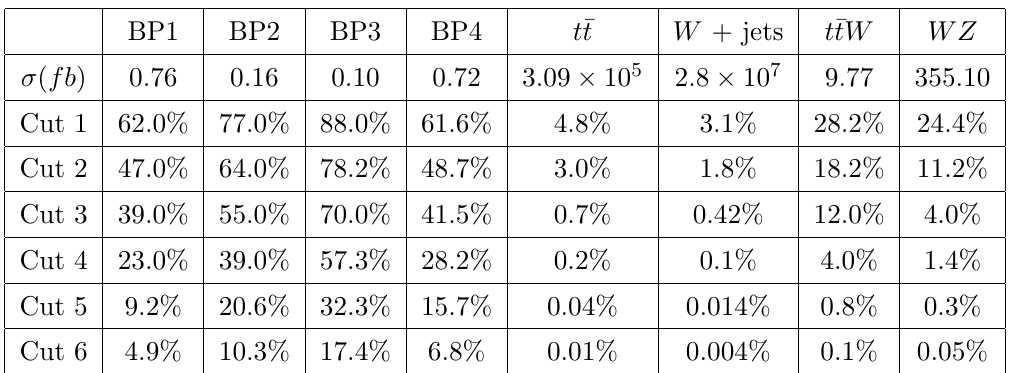
Table 5 . Signal and background e(cid:14)ciencies after applying various cuts for case II at 14 TeV. The cross-sections are calculated at